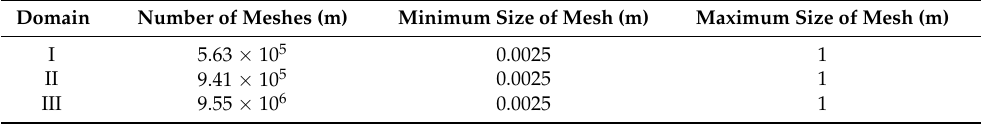
Table 3. Meshes of the computational